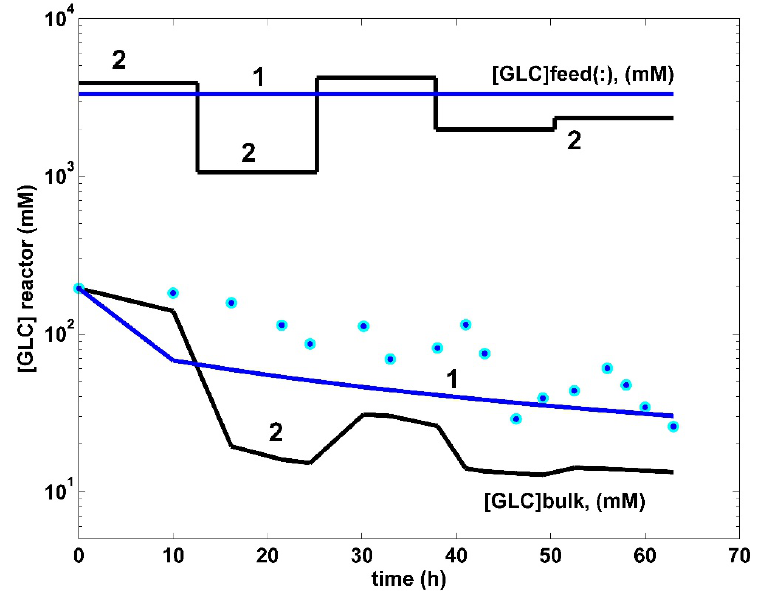
Figure 6. Model-based simulated trajectories (-) for the key species involved in the TRP operon expression module (TRP, OR, mRNA, and E) in the modified E. coli T5 strain for the FBR operated in two alternatives: (i) (2, black) optimal operation derived in this paper (variable fed [GLC] and variable feed flow rate), and (ii) (1, blue) under nominal, nonoptimal operation of Table 1, with a constant fed [GLC] and a constant feed flow-rate. Species abbreviations are given in the abbreviations list.